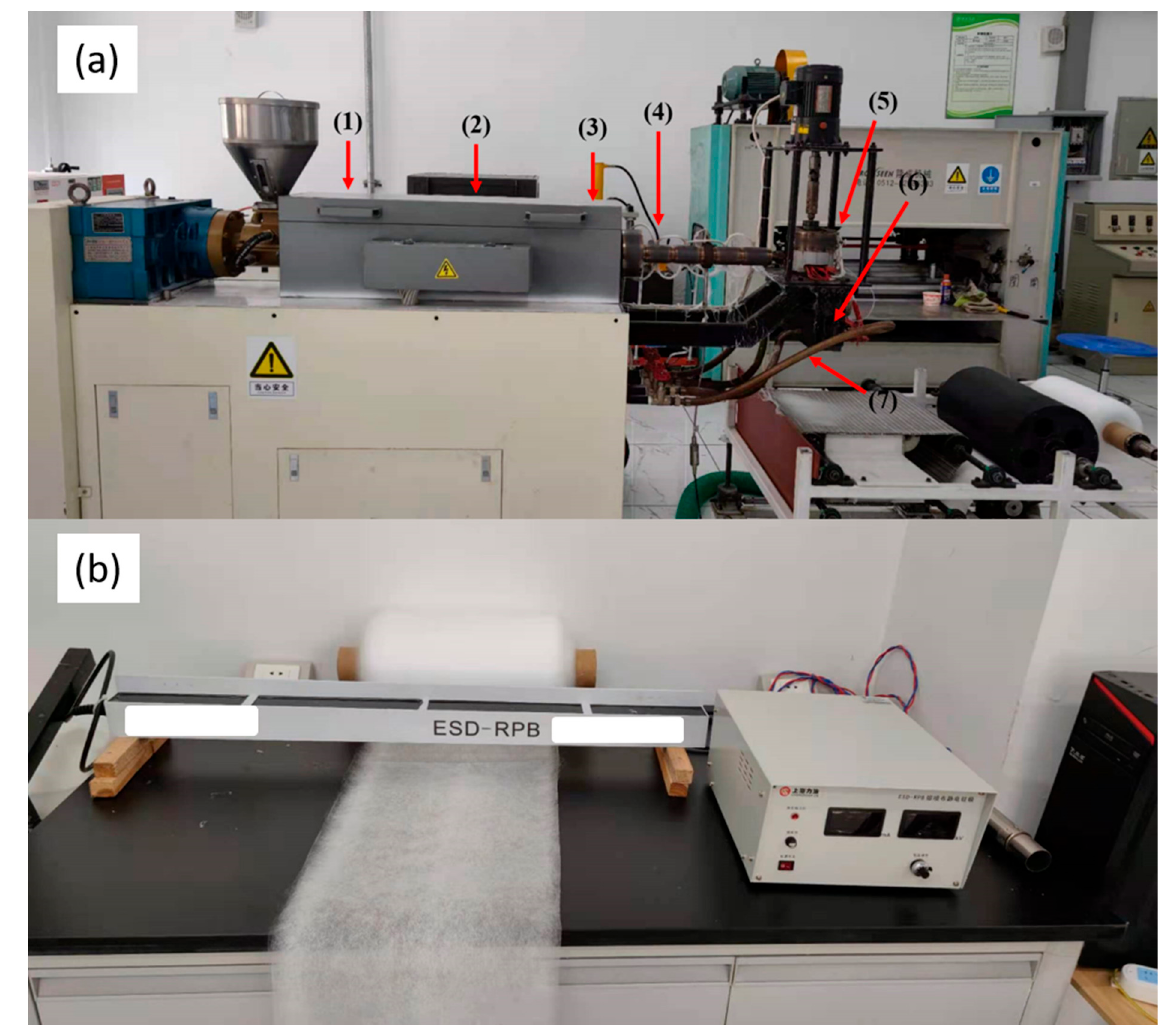
Figure 1. Images of ( a ) the melt blowing machine and ( b ) the electrostatic electret machine. Table 1. Processing parameters.